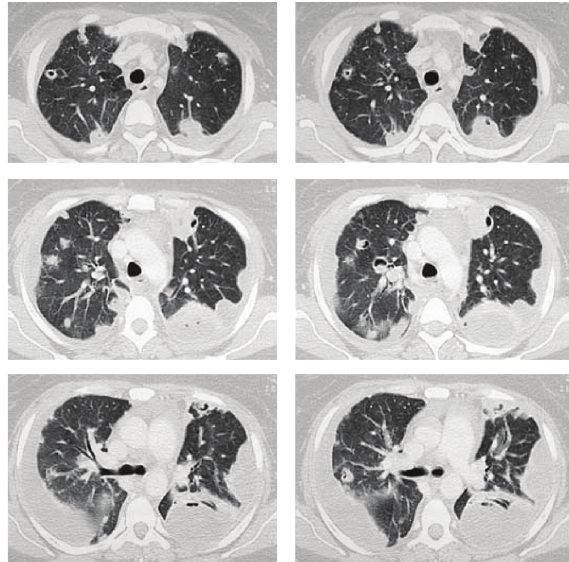
Figure 1: CT scan revealed nodular opacities and di ff use bilateral